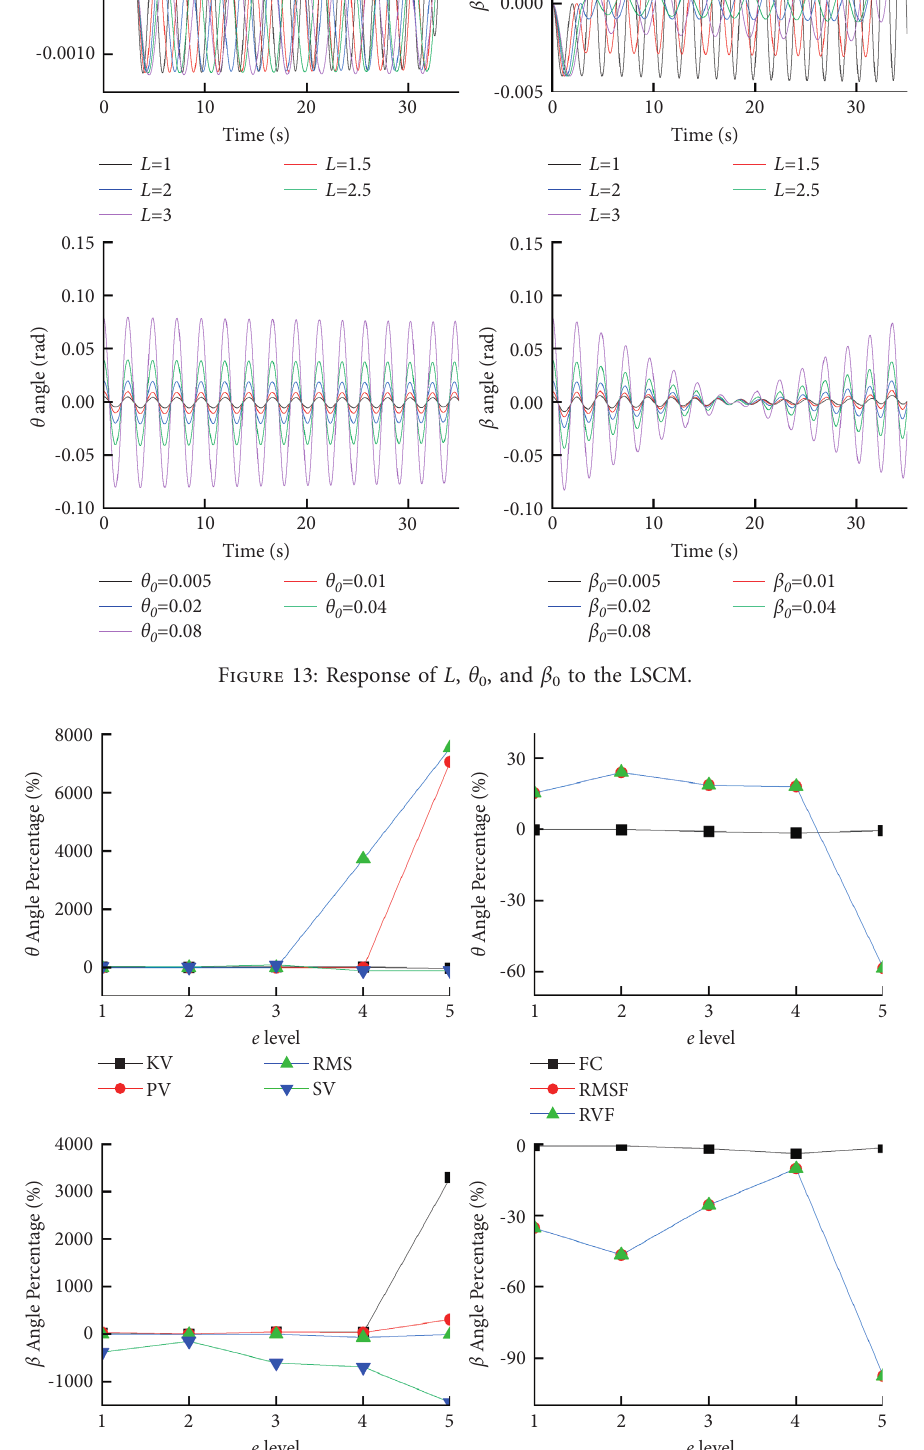
Figure 14: Effect of the lifting acceleration on the lifting-slewing